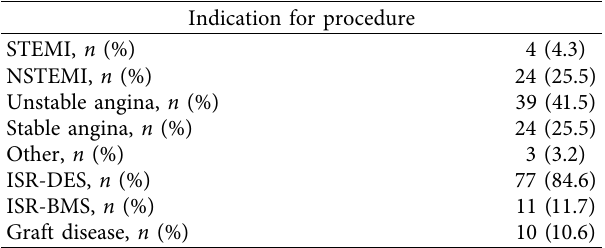
Table 2: Indication for